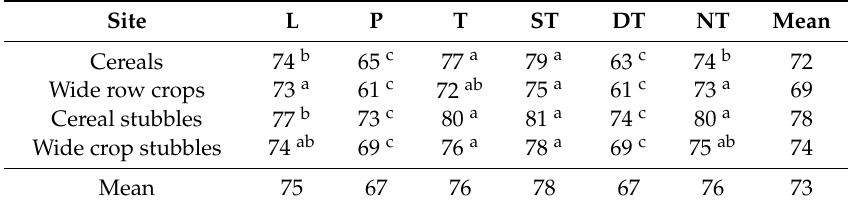
Table 7. Crumb formation% at di ff erent soil and site